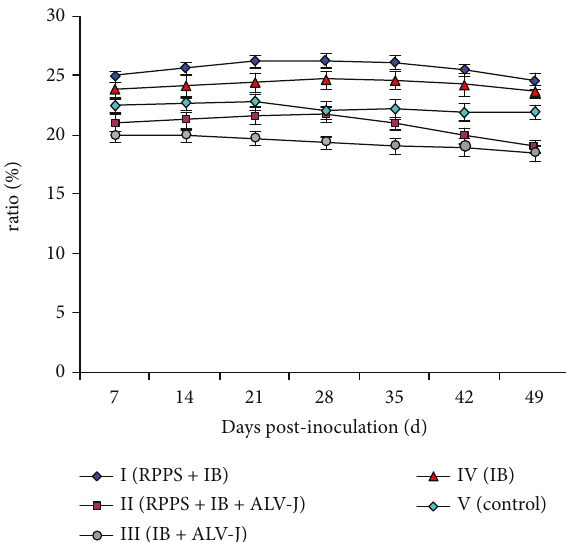
Figure 5: E ff ect of RPPS on blood lymphocyte transformation rate in chickens